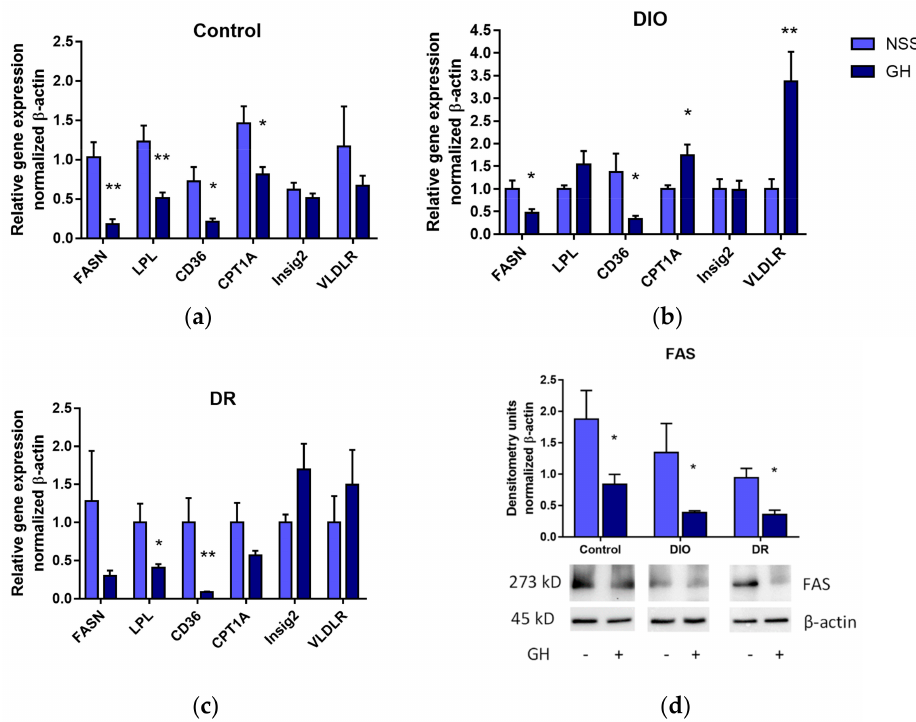
Figure 5. ( a ) The liver mRNA expression in the control group; *, ** represents statistical significance between GH and NSS groups ( p < 0.05, p < 0.01, respectively). ( b ) The liver mRNA expression in the DIO group; * represents statistical significance between GH and NSS groups ( p < 0.05). ( c ) The liver mRNA expression in the DR group; *, ** represents statistical significance between GH and NSS groups ( p < 0.05, p < 0.01, respectively). ( d ) Liver FAS protein levels; * represent statistical significance differences between GH and NSS groups ( p < 0.05). All results are presented as mean ± SEM; n = 6 per experimental group (NSS/GH of control and DIO rats), n = 5 per experimental group (NSS/GH of DR